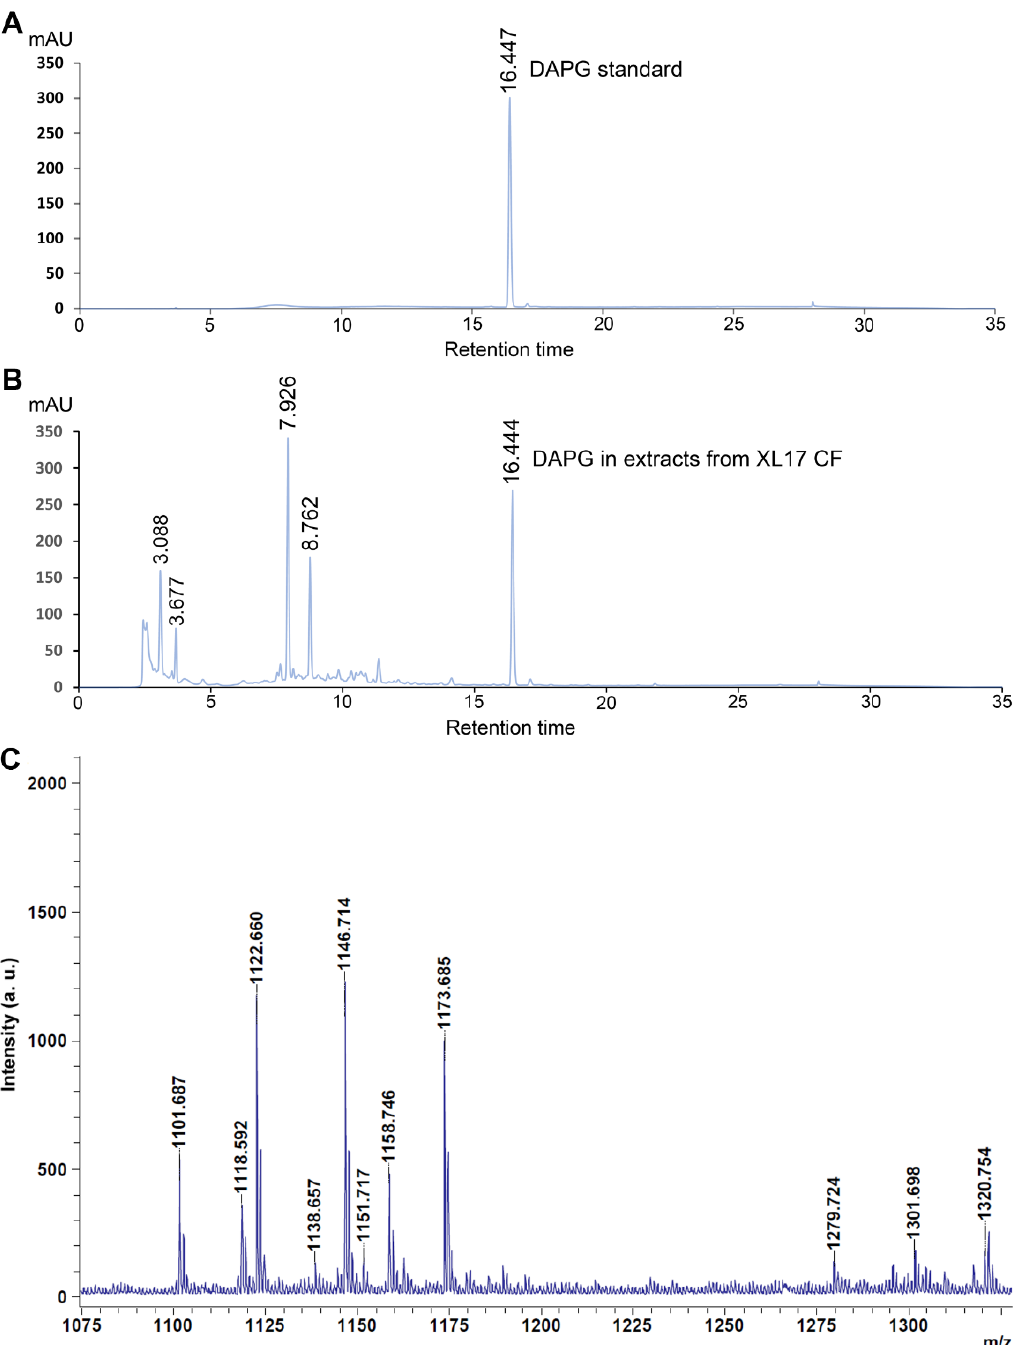
Figure 8. Strain XL17 produces polyketide 2,4-diacetylphloroglucinol (DAPG) and lipopeptides. ( A ) Standard DAPG (10 µg·mL − 1 ) detected by high-performance liquid chromatography (HPLC) has a retention time of 16.447. ( B ) DAPG detected from organic extracts of cell-free culture filtrate (CF) of